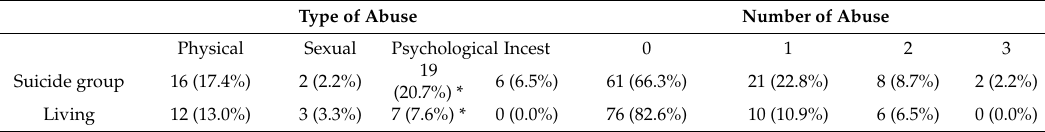
Table 2. Early maltreatment: types and number of abuse among groups in the five-to-nine age period. Type of Abuse Number of Abuse Physical Sexual